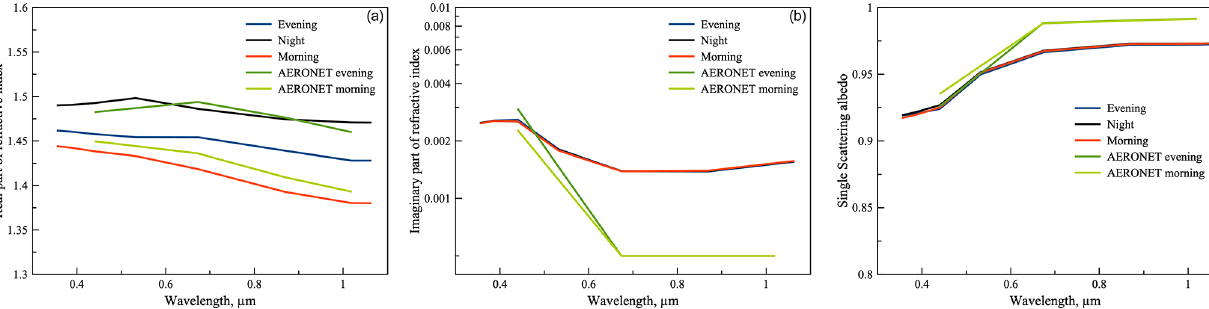
Figure 14. Real (a) and imaginary (b) parts of aerosol complex refractive indices and corresponding single scattering albedos (c) retrieved on 15–16 April 2015. Values retrieved before and after the advanced lidar observation in a combination with Sun-photometer data are shown in blue and red, and those retrieved by AERONET are in dark and light green, respectively.